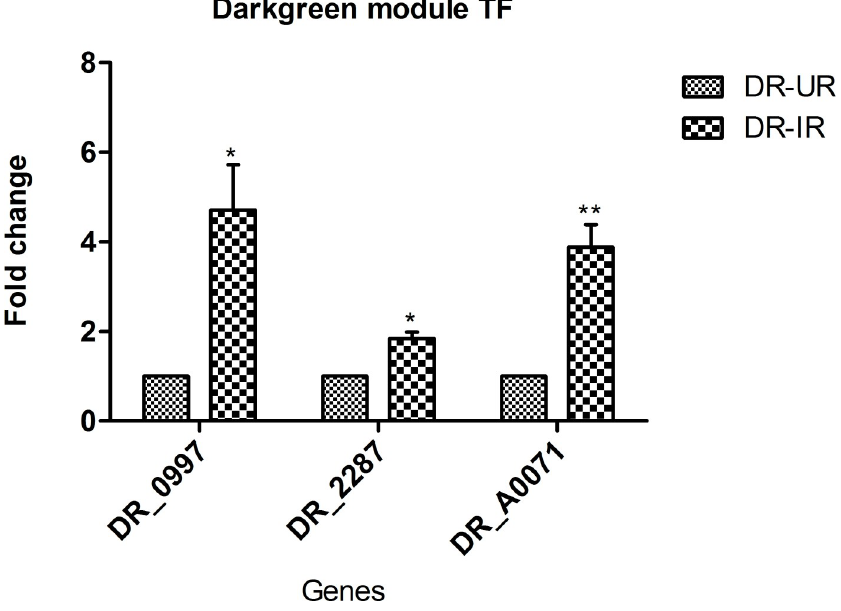
Fig 5. Bar graph of qRT-PCR of TFs in a radiation associated module. Expression profile of 3 TFs which are highly correlated to the hub gene in darkgreen module were checked at 90 minutes of PIR (Radiation dose—6 kGy) in WT D . radiodurans . Error bars indicate Mean ± SD. � p value � 0.05, �� p value � 0.01.